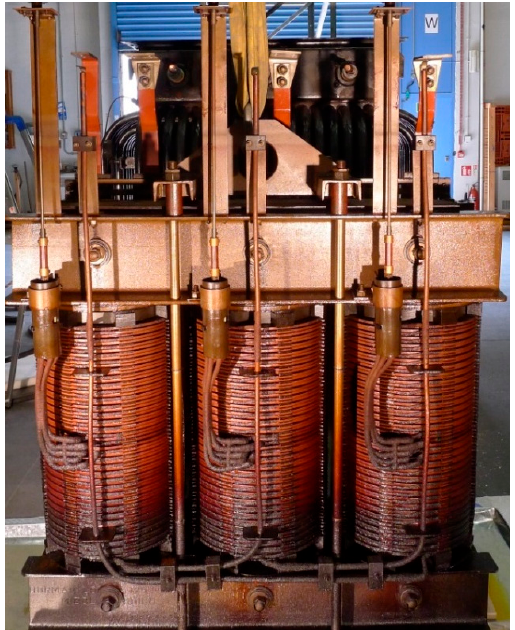
Energies 2019 , 12 , x FOR PEER REVIEW 4 of 13 Figure 1. Front view of the core and winding assembly of 6.4/0.4 kV distribution transformer. Figure 1. Front view of the core and winding assembly of 6.4 / 0.4 kV distribution transformer.